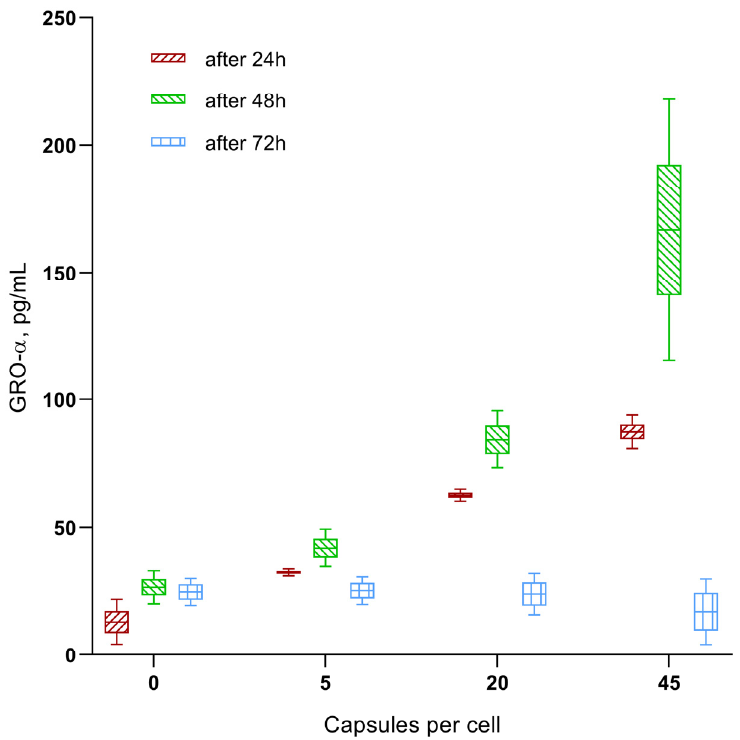
Figure 5. In vitro secretion of GRO- α chemokine by hAMSCs after 24–72 h of microcapsules inter- nalization in different doses. Mean; Box: Mean ± SE; Whiskers: Mean ± SD.